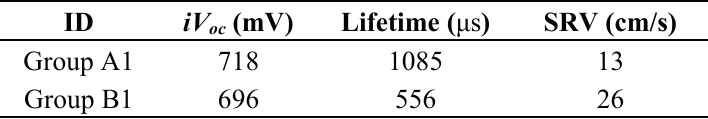
Figure 2. Control sample and two groups of test samples for n and n + epitaxial layers and their passivation. Table 2. iV oc and J 0 components for samples in Figure